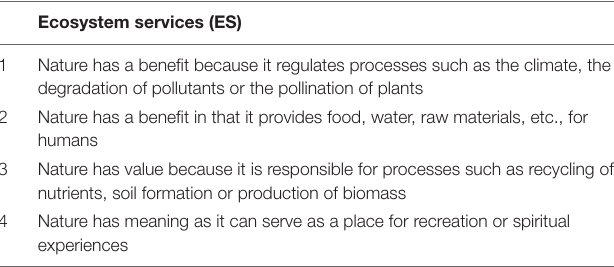
TABLE 3 | Questions for testing discriminant